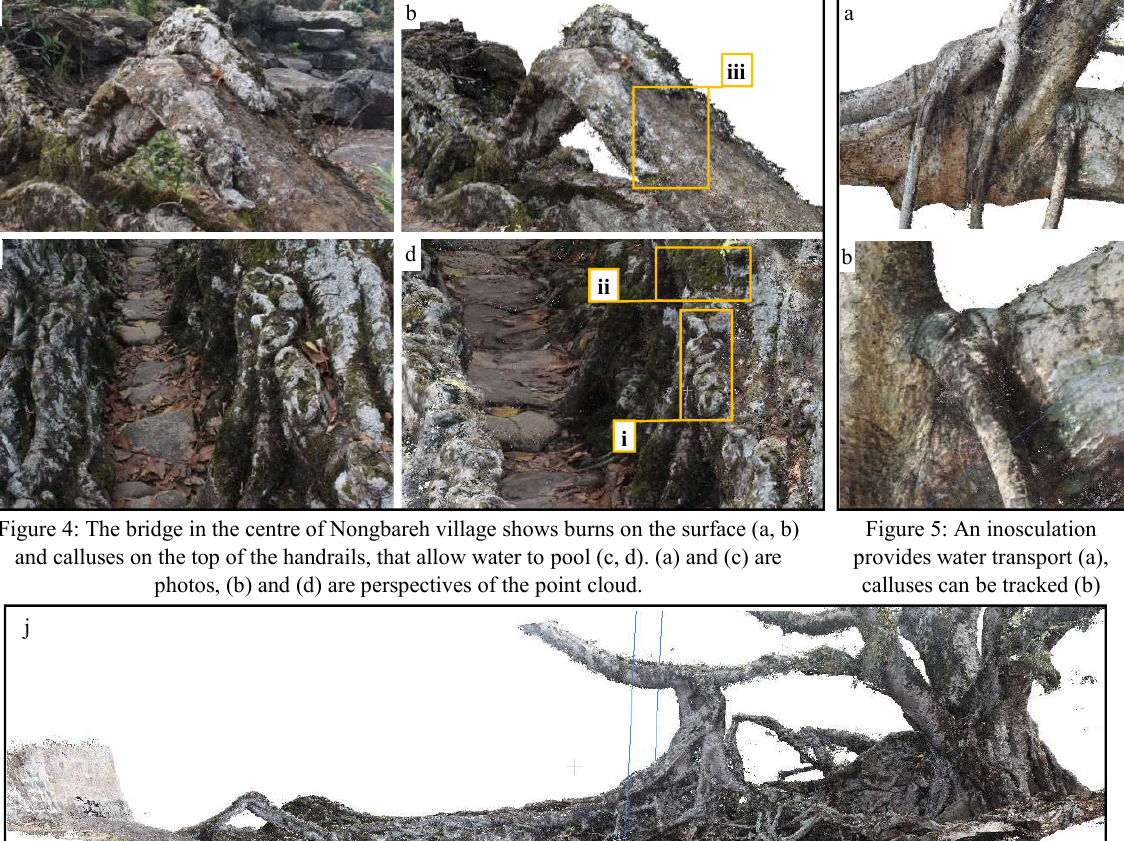
Figure 6: The Amlayeh River under Nongbareh bridge can be mapped in the dry season before floods in July.